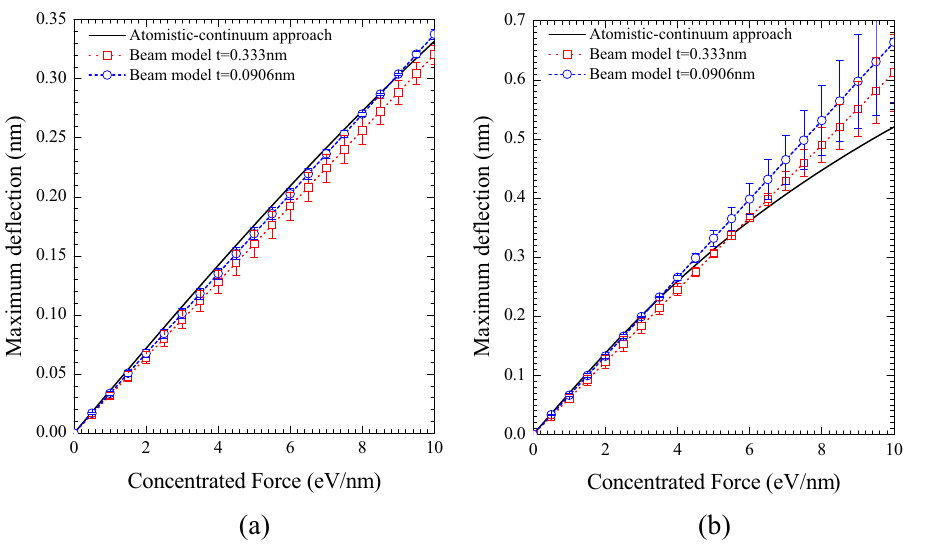
Figure 4: The midpoint bending de fl ection of 15 nm long simply supported ( 8, 8 ) ( a ) and ( 10,10 ) ( b ) BNNTs. A linear relation between the transverse load and bending de fl ection is observed at the fi rst half, while a clear nonlinear relation is observed at the latter